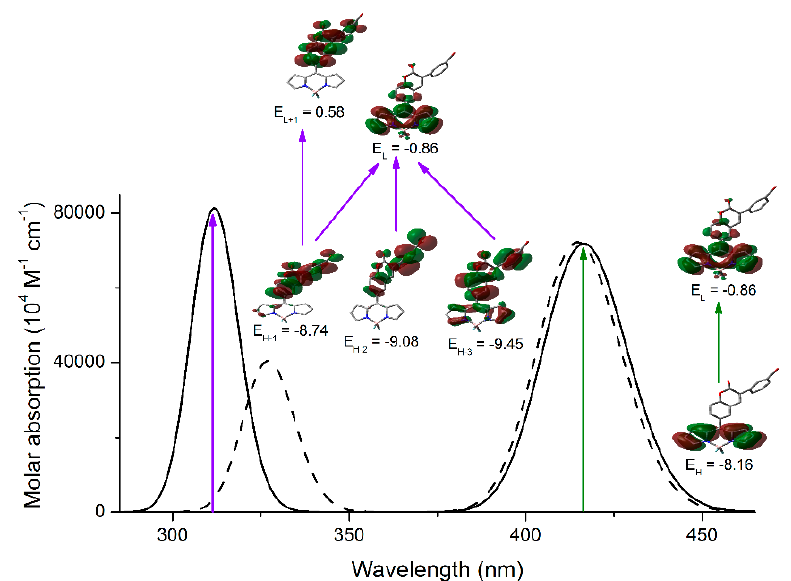
Figure 3. Predicted absorption spectrum (td wb97xd/6-311+g*) and main molecular orbitals and energies (in eV) involved in the electronic transitions for dyad 6 . The corresponding spectrum for reference compound 3 (dashed line) is added for comparison. The predicted absorption spectra and molecular orbitals for other representative dyads with π -extended coumarins are collected in Figure S2 in Supplementary Materials.